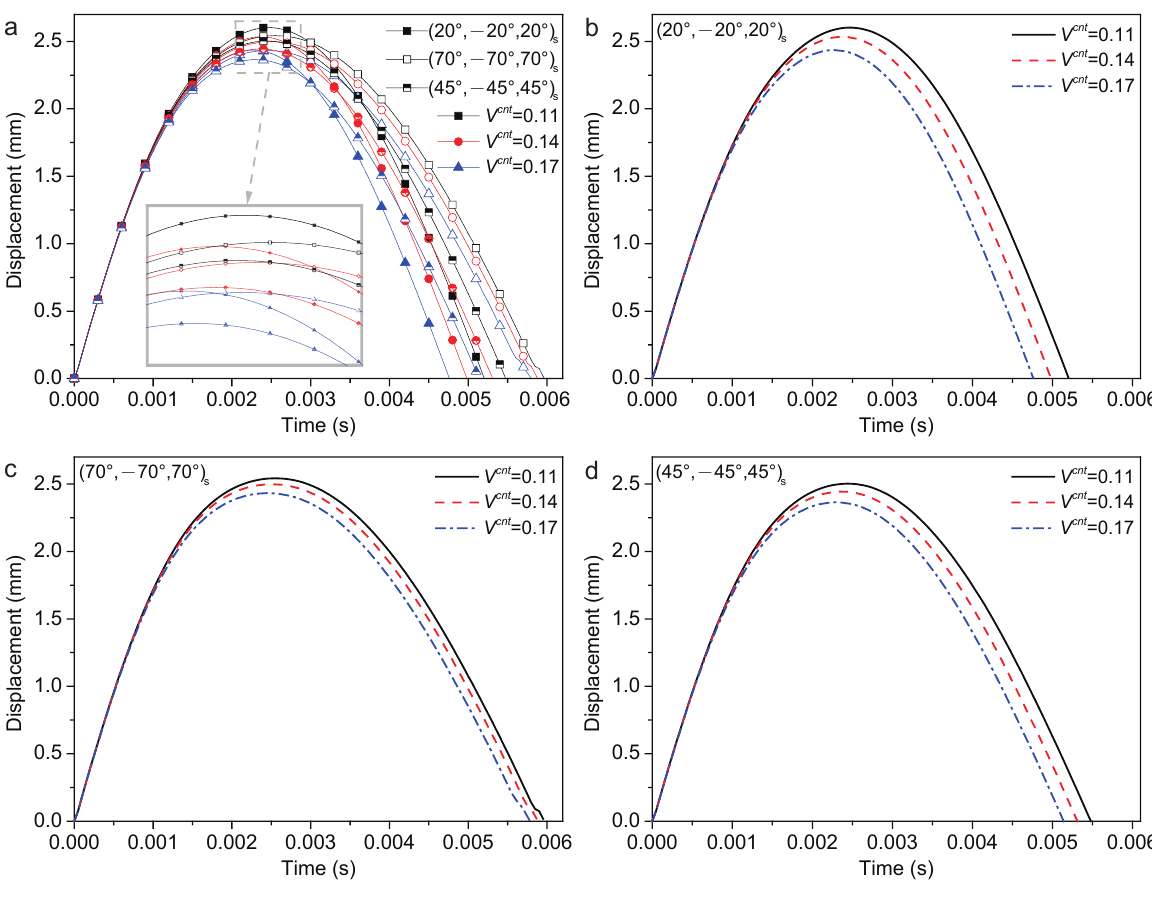
Figure 9. Plate center displacement response of the sandwich structure with various volume fractions of CNTs: ( a ) FG-O, UD and FG-V face sheets plate; ( b ) (20/ − 20/20)s plate; ( c ) (70/ − 70/70)s plate; ( d ) (45/ − 45/45)s